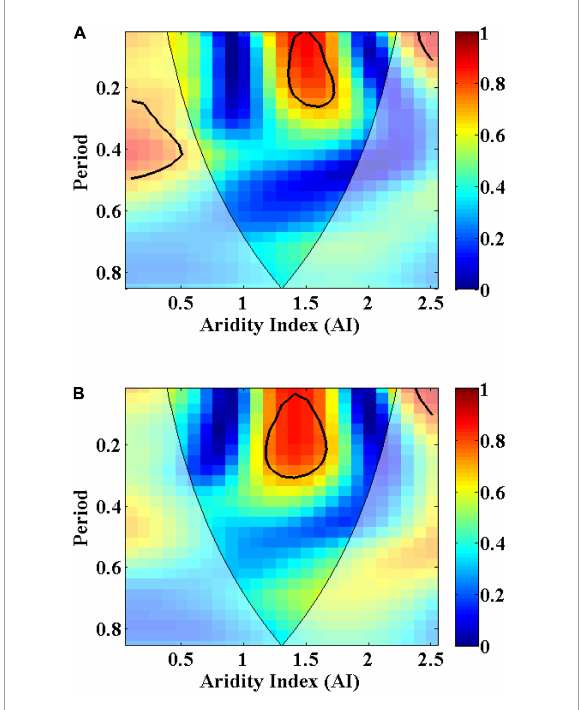
FIGURE3 Wavelet coherence analysis between stem HSM and TLP for (A) all woody species and (B) evergreen woody species paired according to AI intervals at global scale. Red reflects perfect correlation while blue reflects a lack of correlation. The thick black contour represents the 95% significance level against red noise. The y label means the period of strong local correlation. In this study, the strong correlation only for AI between 1.3 and 1.5, and the corresponding y label value is about 0.2. It means that the period of strong local correlation is 0.2 (just the interval between 1.3 and 1.5). Because the edge effects cannot be ignored, we only focus on the data inside the Cone of Influence (COI) (darker